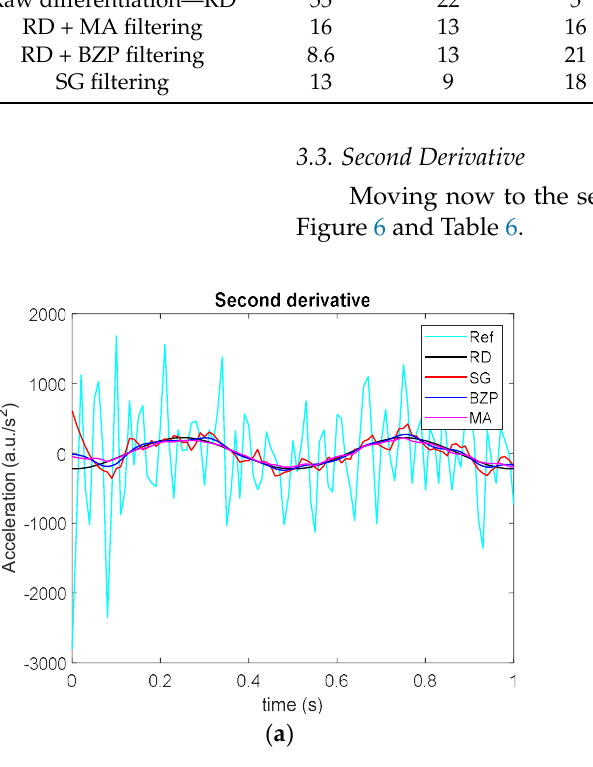
Figure 5. Signal differentiation. ( a ) Time histories for analytical signal first derivative (Reference, Ref), numerically differ- entiated signal (raw differentiation, RD), differentiated and filtered by polynomial (SG), Butterworth (BZP) or moving average (MA), and; ( b ) first derivative errors for all the methods. Table 5. Performance indicators for the first derivative obtained by raw numerical differentiation (RD) and low pass filtering or by polynomial filtering (SG) on the original 2 and 5 Hz noisy time signals. Signal/Indicator